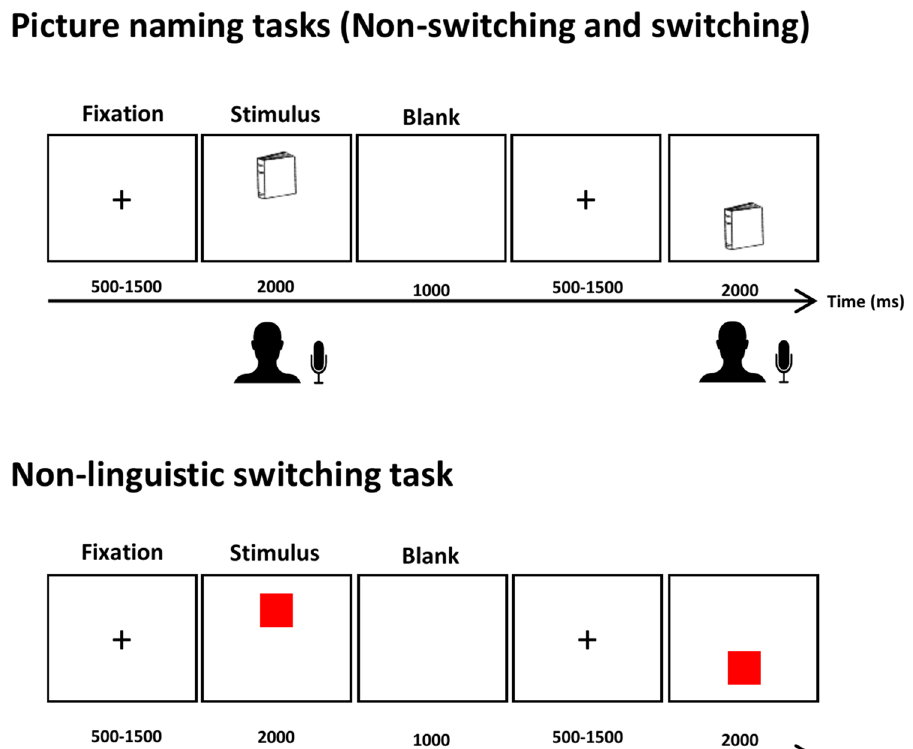
Figure 1. Task procedure; switching and nonswitching picture-naming and nonlinguistic switching tasks. In switching picture-naming (i.e., the linguistic switching task) participants had to name the pictures in L1 when the picture appeared on the top and name the picture in L2 when it appeared on the bottom of the